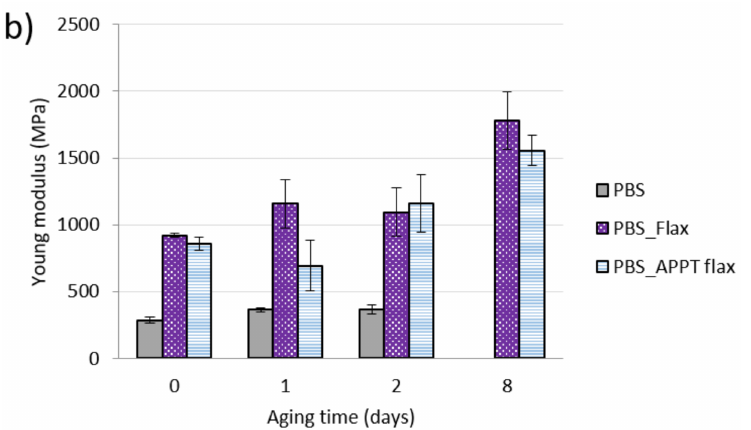
Figure 16. Mechanical properties of PBS materials during aging time. ( a ) Tensile strength and ( b ) Young’s